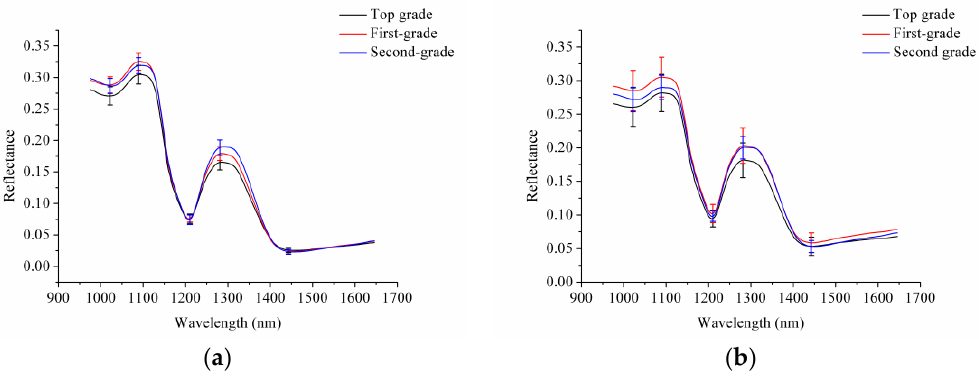
Figure 2. ( a ) Average spectra with SD of the wavelengths at the spectral peaks and valleys for three grades of intact sausages, and ( b ) average spectra with SD of the wavelengths at the spectral peaks and valleys for three grades of sliced sausages. The bold lines refer to the average spectra, and the vertical lines of the corresponding color indicate the SD of the wavelengths at the spectral peaks and valleys.